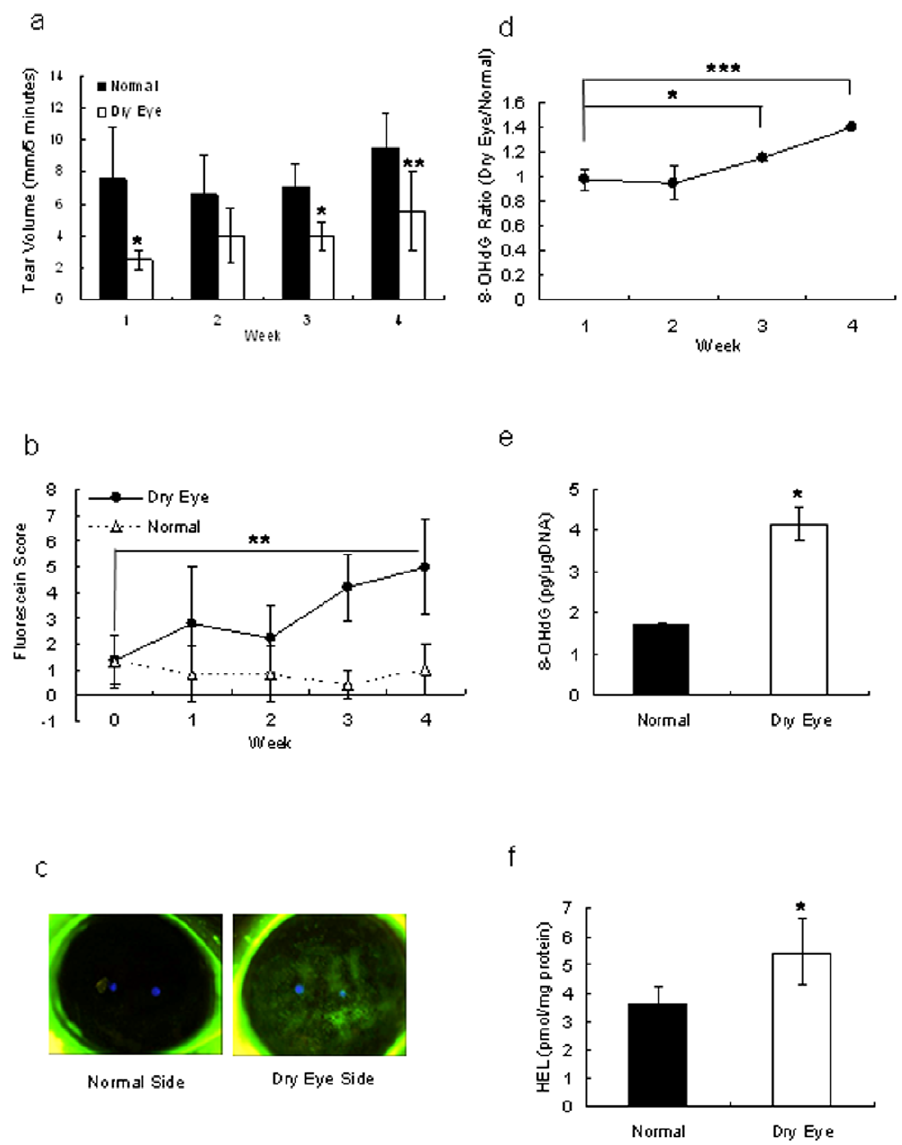
Figure 1. Preparation of dry eye rat model. a: Measurement of tear volume secreted from normal eye or lacrimal gland-removed eye of rats. The vertical axis shows tear volume measured by cotton thread. Results are expressed as mean 6 S.D. Dunnett’s test was used to determine the significance of differences. * and **indicates a significant difference from the result in normal side, P , 0.05 and , 0.01, respectively. b: Corneal fluorescein staining in normal rats and rats with dry eye. The vertical axis shows score of the fluorescein-stained area. Dunnett’s test was used to determine the significance of differences. ** indicates a significant difference from the result at 0 week, P , 0.01 (n=10). c: Photo of cornea stained by fluorescein after 4 weeks treatment. d: Increase of marker during oxidative stress. Ratio of 8-OHdG content in the cornea between the dry eye and normal eye. Results are expressed as mean 6 S.D. Dunnett’s test was used to determine the significance of differences. * and *** indicates a significant difference from the result in 1-week removal, P , 0.05 and , 0.005, respectively. e, f: Oxidative stress markers in cornea of normal rats and rats with dry eye. Contents of 8-OHdG (e) and HEL (f) in a dry eye and normal corneas. t-test was used to determine the significance of differences. * indicates a significant difference from the result in normal side, P , 0.05. Results are expressed as the mean 6 S.D.